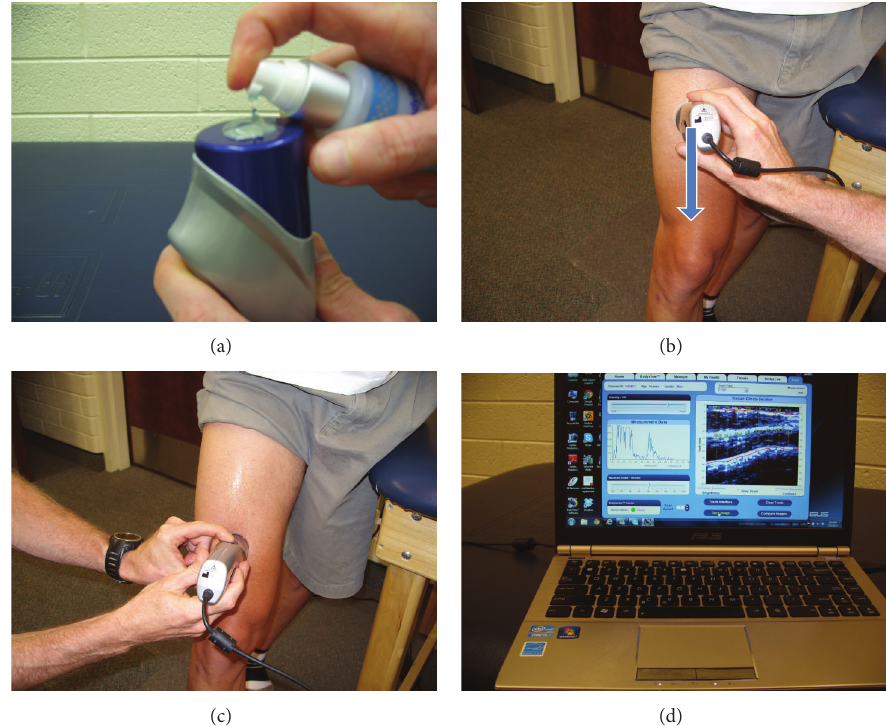
Figure 2: Measurement sequence for an ultrasound image scan of the thigh. (a) Gel applied to the ultrasound head for lubrication. (b) Beginning of scan. (c) End of scan. (d) Scanned image appears on screen and can be saved for future